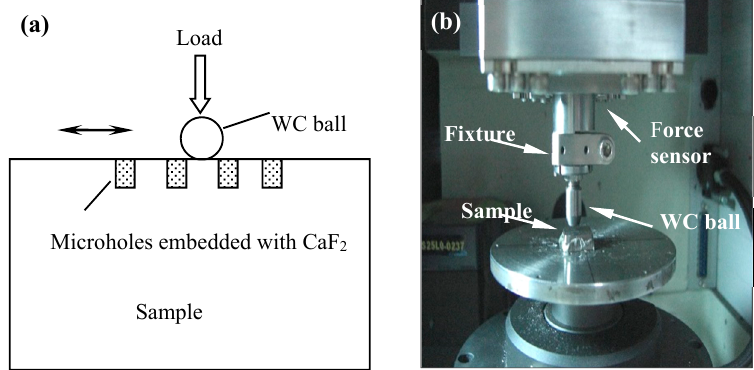
Figure 2. ( a ) Schematic diagram of frictional tester; ( b ) The ball-on-plate tribometer.